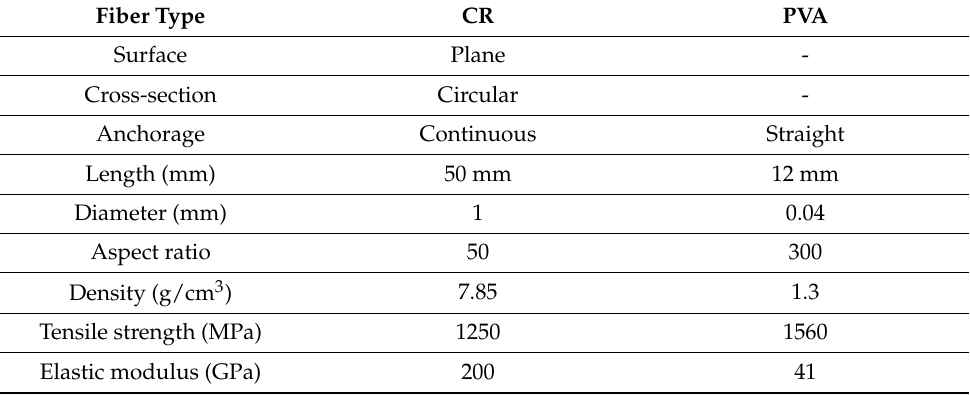
Table 3. Properties of used